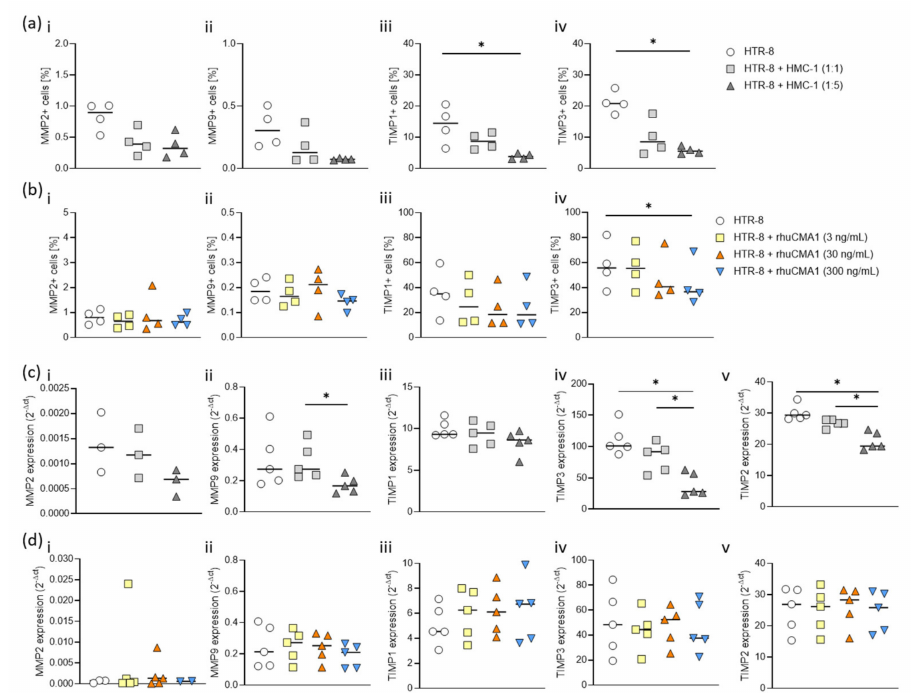
Figure 6. Both HMC-1 and rhuCMA1 downregulate the number of TIMP-positive HTR-8/SVneo cells and TIMP-expression levels. Intracellular protein expression of MMP2 ( i ), MMP9 ( ii ), TIMP1 ( iii ), TIMP3 ( iv ) in HTR-8/SVneo cells after coculture with HMC-1 ( a ) at different cell-to-cell ratios (HTR-8:HMC-1 ratio 1:1 or 1:5) or treatment with rhuCMA1 ( b ) at different concentrations (3 ng/mL, 30 ng/mL, 300 ng/mL) at 24 h was detected by flow cytometry. The mRNA expression of MMP2 ( i ), MMP9 ( ii ), TIMP1 ( iii ), TIMP2 ( iv ) and TIMP3 ( v ) in HTR-8/SVneo cells after coculture with HMC-1 ( c ) at different cell-to-cell ratios (HTR-8:HMC-1 ratio 1:1 or 1:5) or treatment with rhuCMA1 ( d ) at different concentrations (3 ng/mL, 30 ng/mL, 300 ng/mL) at 72 h was measured by RT-PCR. The results are presented as a median. Statistical analysis was performed with the Friedman test (* p < 0.05). HTR-8: HTR-8/SVneo; rhuCMA1: recombinant human chymase; MMP: